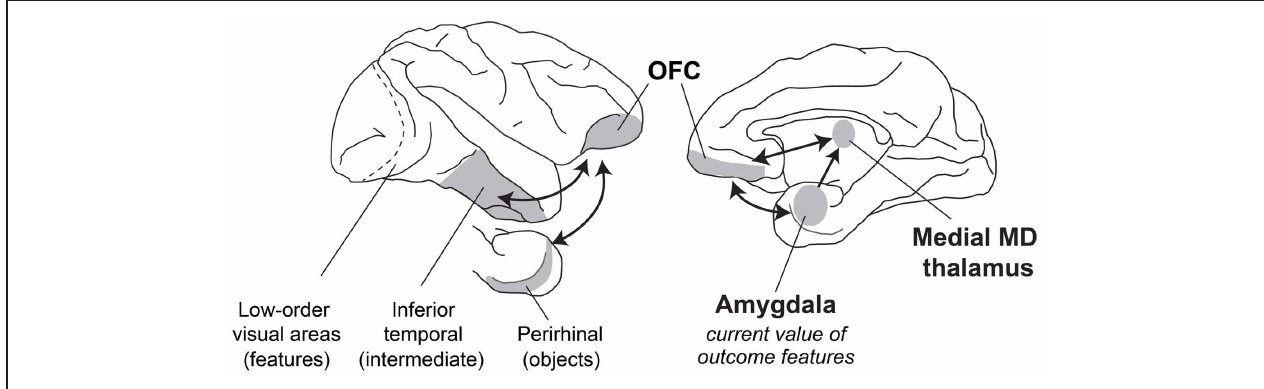
FIGURE 5 | A schematic of brain structures involved in devaluation. Lateral (left) and medial (right) views of the macaque brain showing locations of structures involved in devaluation. Visual information from the retina is processed in primary visual cortex and then in a series of cortical fields terminating in inferior temporal cortex. More rostral regions of inferior temporal cortex, including the multimodal perirhinal cortex, represent more